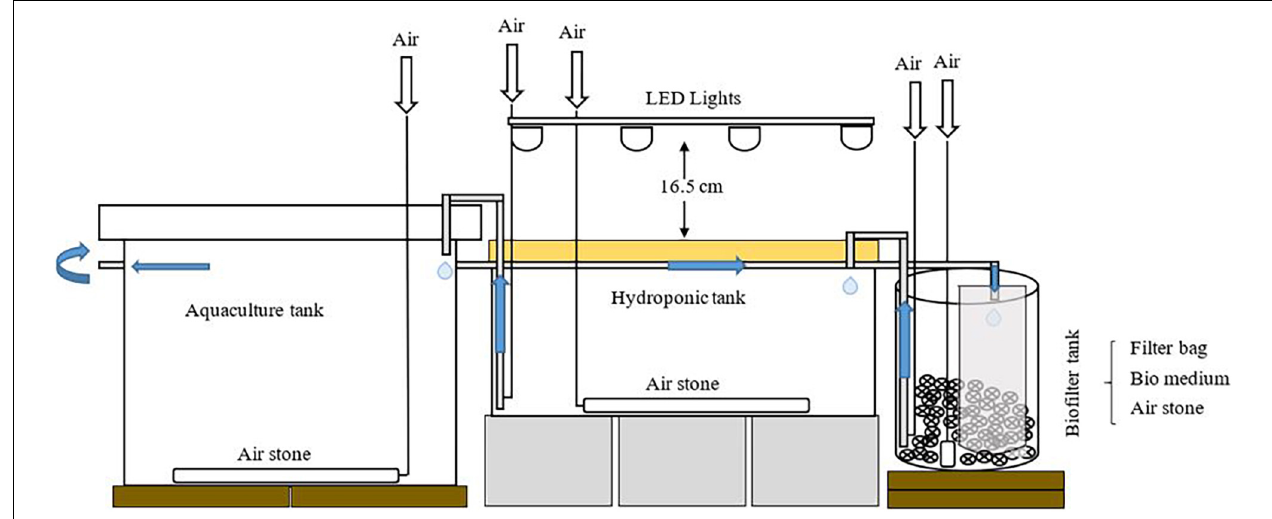
FIGURE 1 | Schematic diagram of an aquaponics system unit (adapted from Chu and Brown (2021); https://creativecommons.org/licenses/by/4.0/).